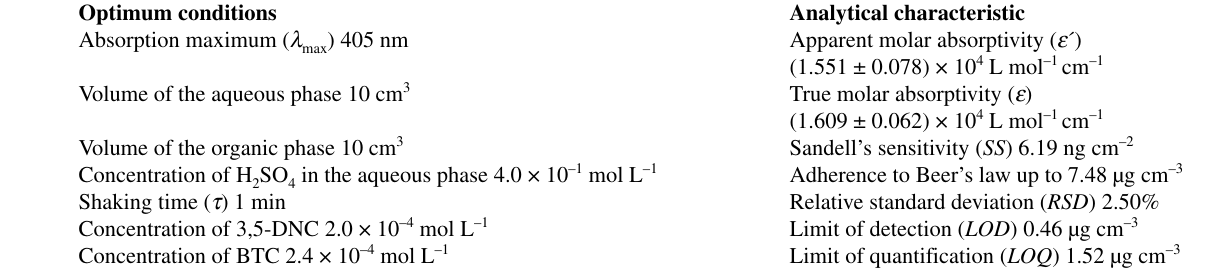
Table 1. Optimum extraction-spectrophotometric conditions and analytical characteristics of the system Mî(VI)–3,5-DNC–BTC–H Optimum conditions Analytical